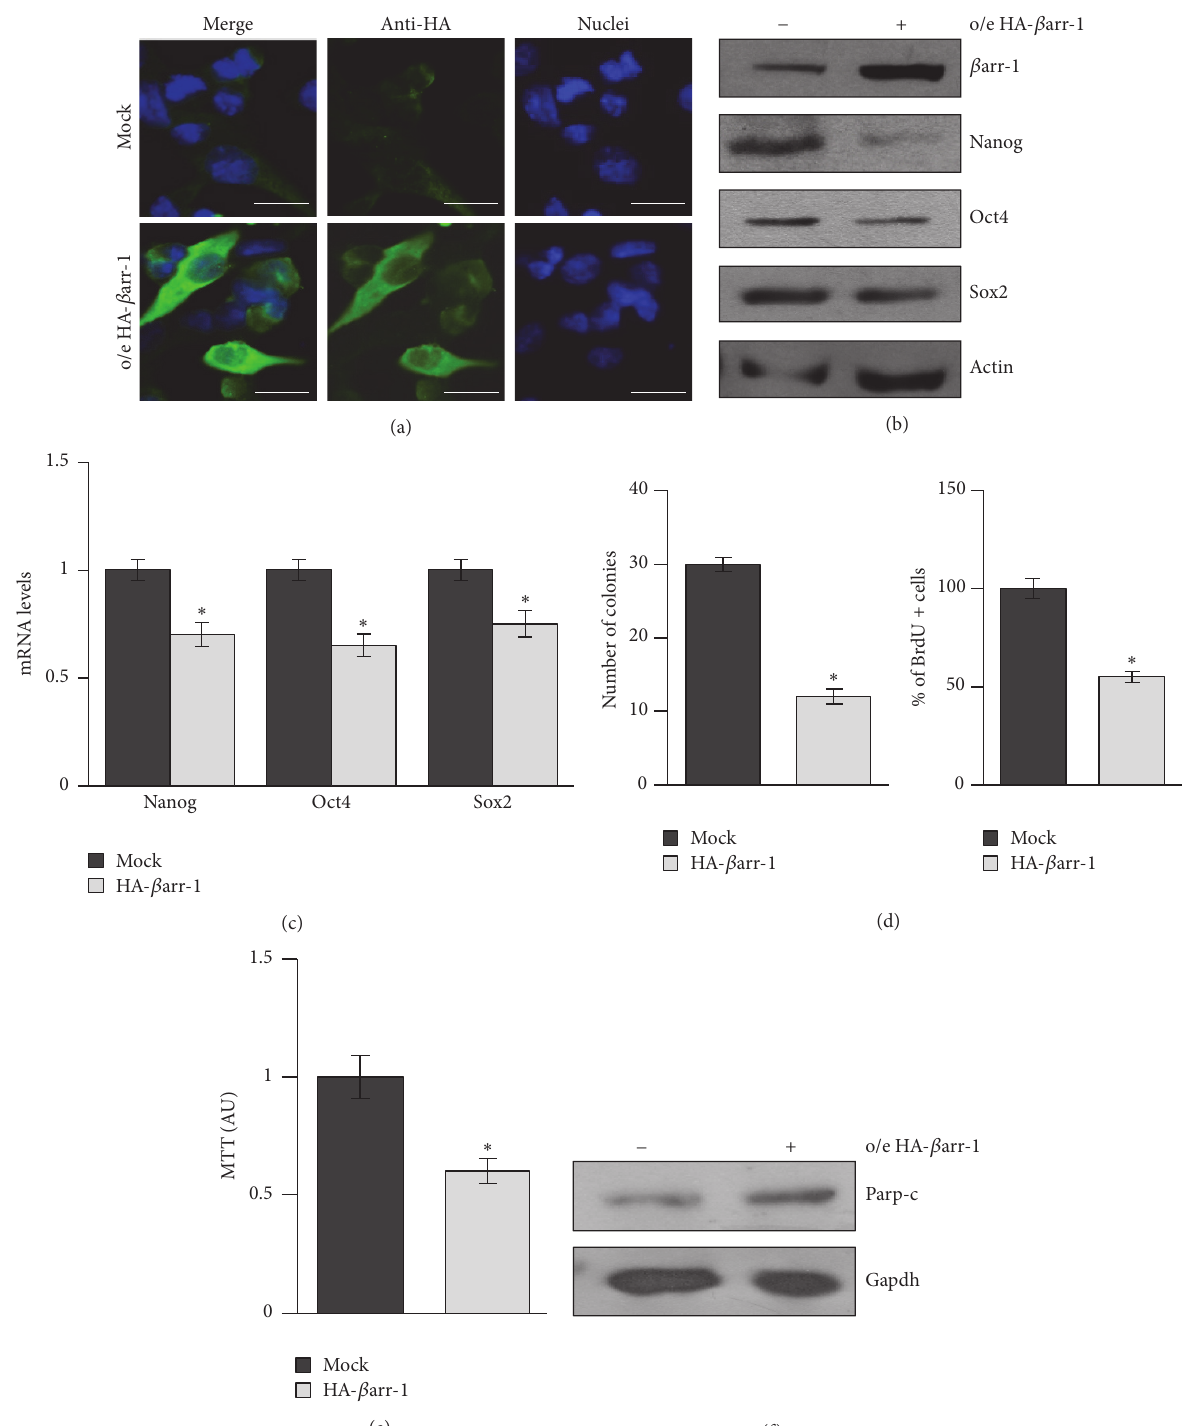
Figure 4: 𝛽 arr-1 overexpression impairs NSCs clonogenicity and proliferation. (a) Representative image of immunofluorescence staining of NSCs after overexpression of HA- 𝛽 arr-1. Nuclei are counterstained with Hoechst. Scale bar: 5 𝜇 m. (b) WB analysis of endogenous stemness markers in NSCs after overexpression of HA- 𝛽 arr-1. Loading control: actin. Representative Western blot images from 3 independent experiments. (c) mRNA expression levels of stemness markers in NSCs after overexpression of HA- 𝛽 arr-1. (d) Oncosphere forming assay (number of colonies, left panel) and bromodeoxyuridine (BrdU) uptake (right panel) in NSCs after ectopic expression of HA- 𝛽 arr-1. (e) Cell viability (MTT assay) in NSC after ectopic expression of HA- 𝛽 arr-1. (f) WB analysis of cleaved Parp (Parp-c) in NSCs after overexpression of HA- 𝛽 arr-1. Loading control: Gapdh. Representative Western blot images from 3 independent experiments. ((c), (d), and (e)) Data are means ± SD from 3 independent experiments. ∗ 𝑝 < 0.05